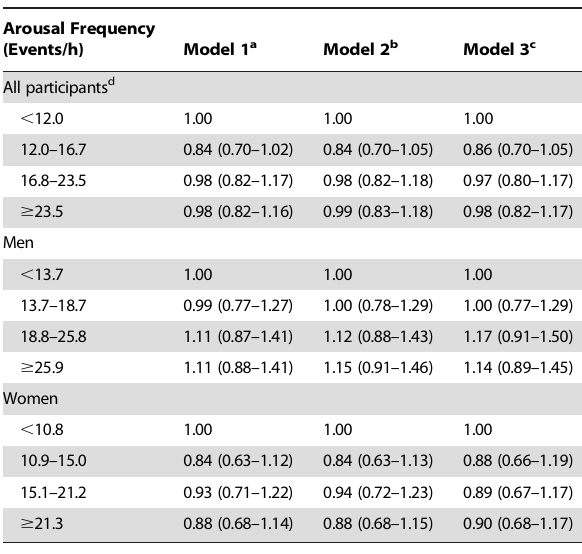
a Model 1: Adjusted for age (continuous) and race. b Model 2: Adjusted for covariates of model 1 and body mass index (continuous). c Model 3: Adjusted for covariates of model 2 and smoking status (never, former, current), hypertension, diabetes, and cardiovascular disease. d Sex was included as a covariate in each of the three models based on all